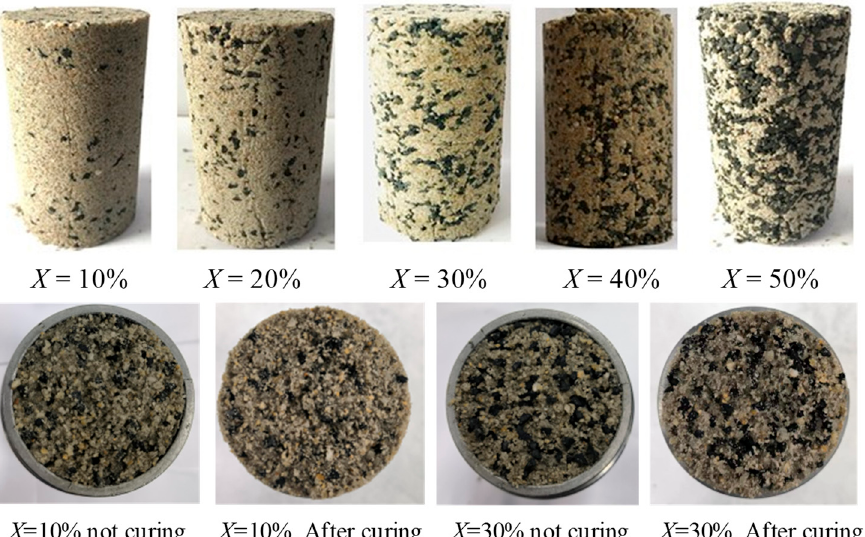
Figure 4. RCS soil samples with rubber contents from 10% to 50%, along with their cross-sections.